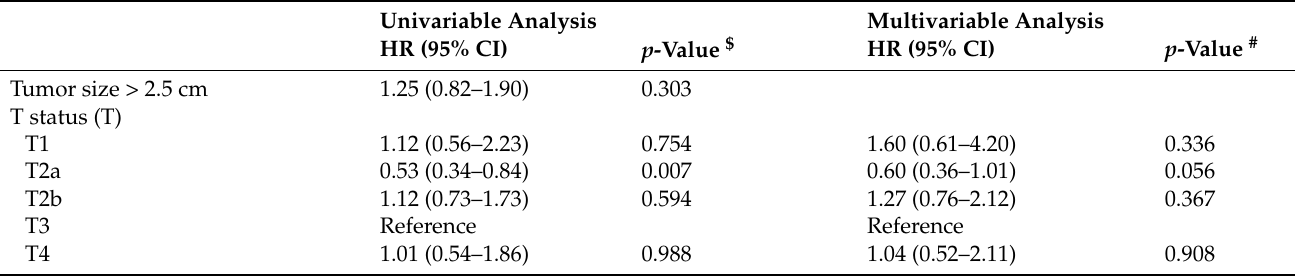
Table 3. Uni- and multivariable Cox regression analysis for recurrence-free